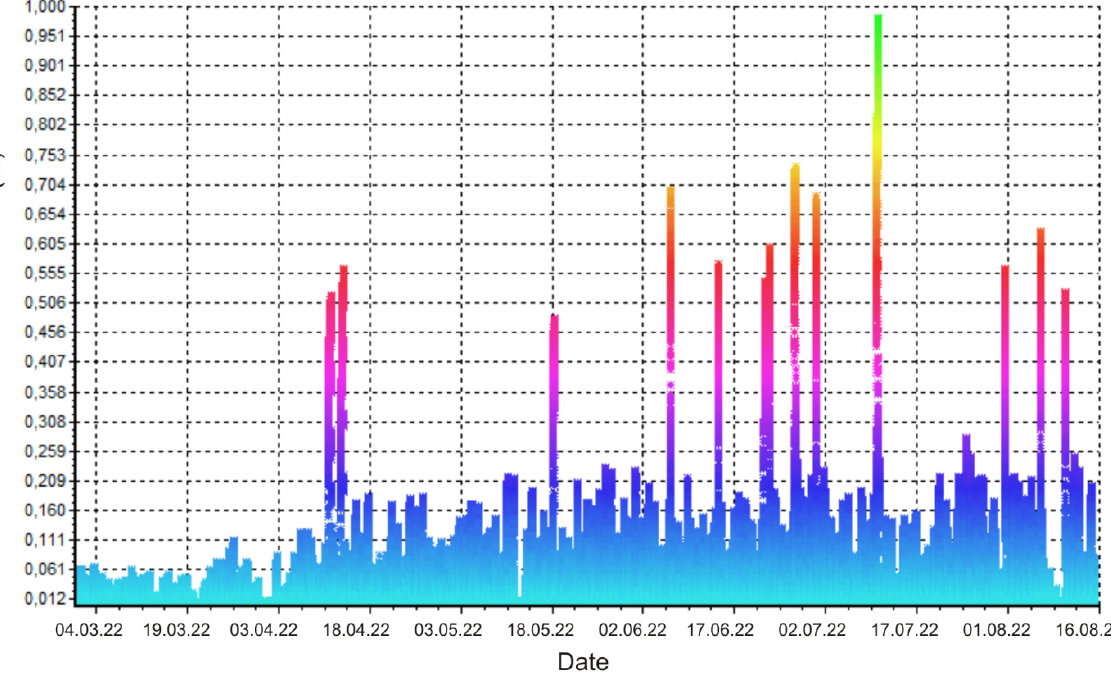
Figure 11. Seasonal dynamics of measured methane (CH 4 ) concentration in near-surface air.